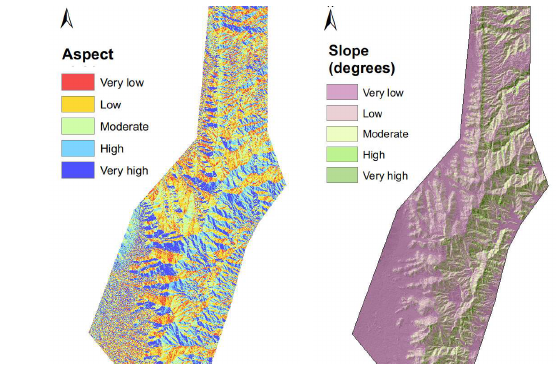
Figure 3. Weighted climate maps